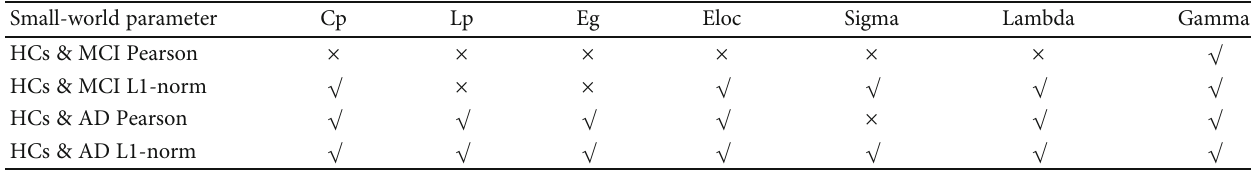
Table 2: Statistical di ff erence in small-world parameters through the Pearson correlation analysis and the sparse L1-norm regularization